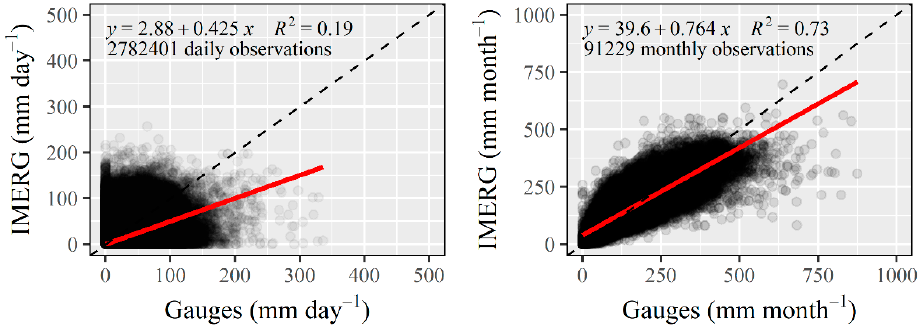
Figure 5. Regressions between daily and monthly data observed by gauges and IMERG.